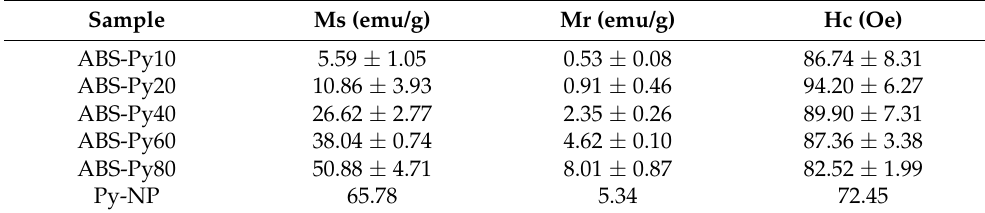
Figure 8. ( a ) Magnetic hysteresis loops-HL- of ABS–Py with different wt% and pristine Py-NP. (Inset) Ms values of the different samples. ( b ) Values of Hc extracted from the HL. ( c ) Values of Mr extracted from the HL. ( d ) Simulated HL for selected diameters. ( e ) Zoom-in of Figure 8d for better observation of the Hc variation. ( f ) Spin configurations at remanence for Py-NP of D = 40 nm and D = 50 nm, after saturation along “x”. Table 4. Summary of the magnetic properties of the ABS and the composites with different content of Py-NP.